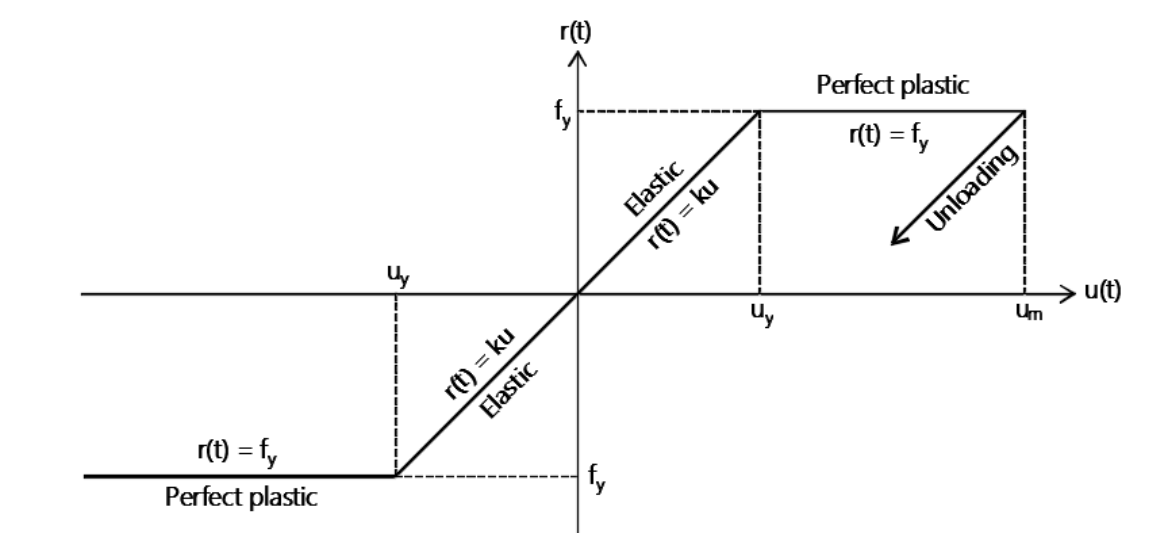
Figure 3. Idealized elastic-perfectly plastic behavior [29].